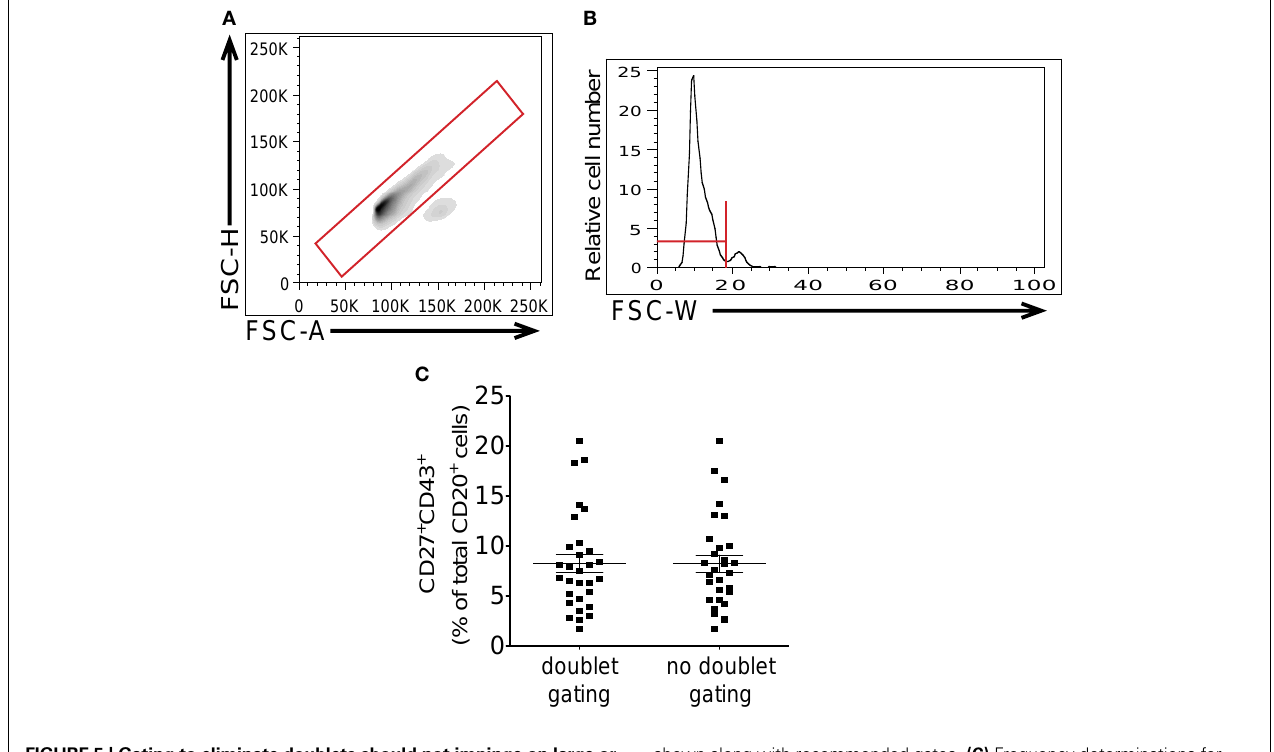
FIGURE 5 | Gating to eliminate doublets should not impinge on large or irregularly shaped cells. Adult peripheral blood mononuclear cells were immunofluorescently stained for CD20, CD27, CD43, and CD3, and were then evaluated by flow cytometric analysis. Examples of doublet discrimination by FSC-H/FSC-A [LSR-II instrument (A) ] and FSC-W [Gallios instrument (B) ] are